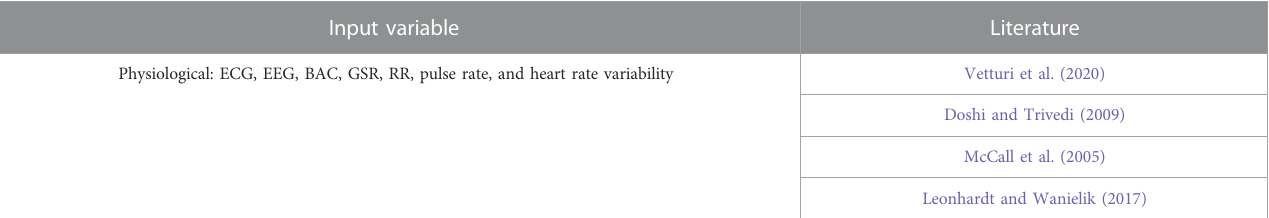
TABLE 3 Summary of physiological